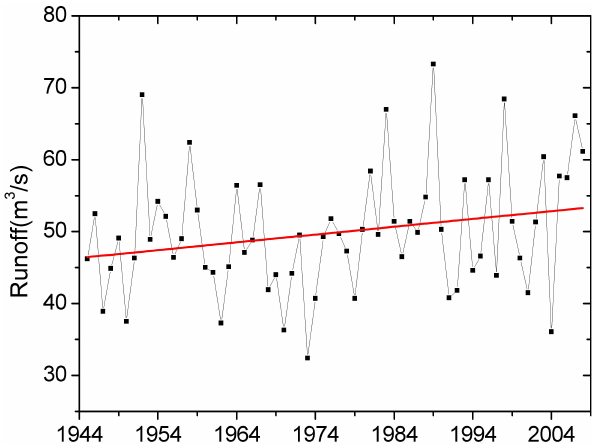
Fig. 6. Average annual runoffs of YingLuoXia hydrologic station.